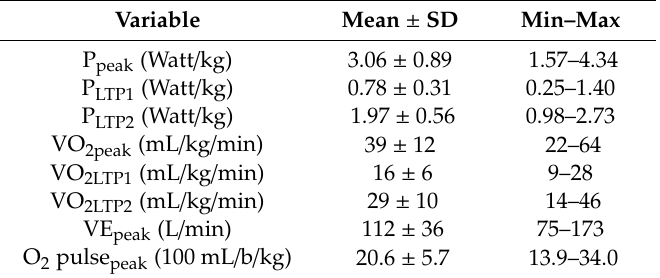
Table 1. Peak cardio-pulmonary exercise test variables.